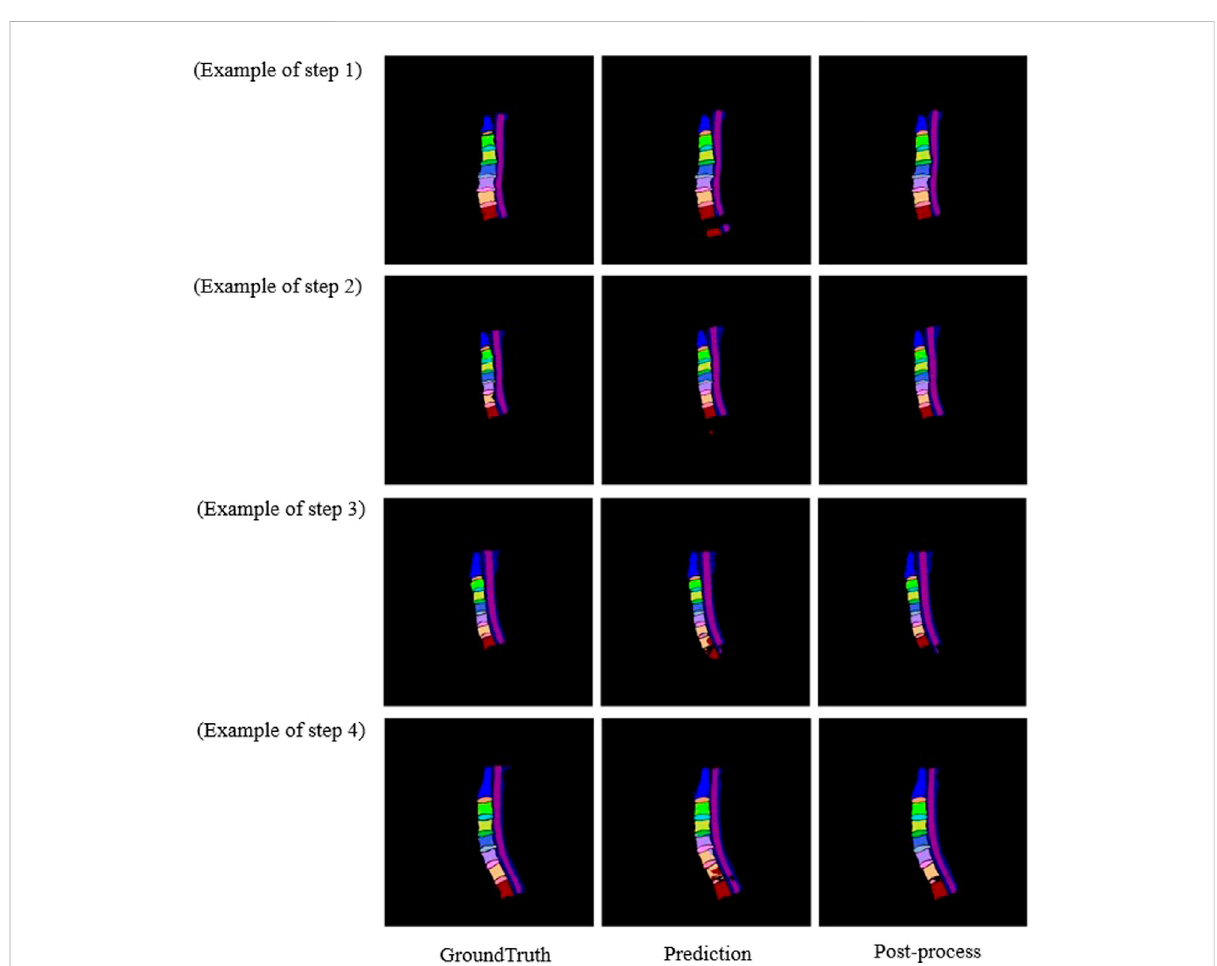
FIGURE 7 Comparison image of the original sample and the post-processing sample of the three